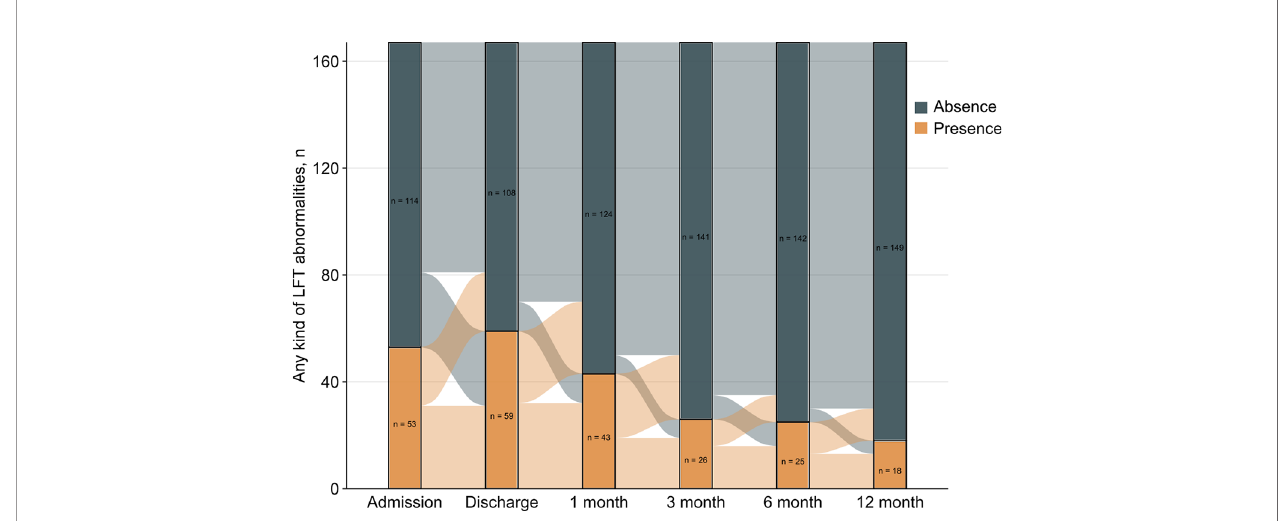
FIGURE 2 | Evolution of liver function tests abnormalities over time for 167 patients with complete data in the study